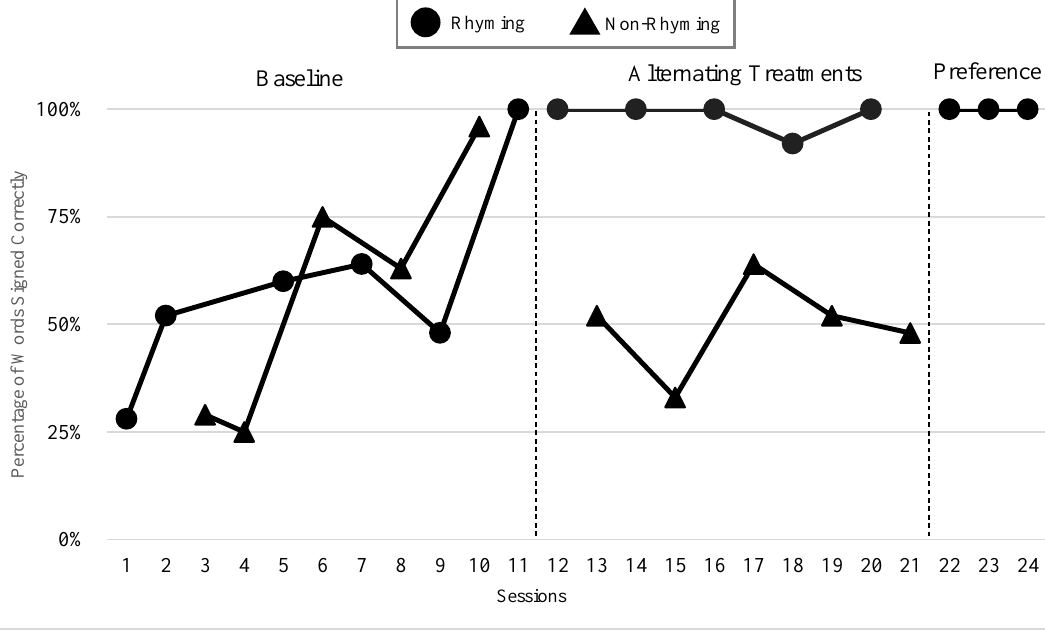
Figure 14. Jaslene’s Percentage of Words Signed in the Correct Order in Recitation. 6.3.4. Lexie Lexie was six years old—the oldest participant in this study—and was adopted from another country two years ago. Lexie came to the United States without any language or lexical vocabulary. After two years of intensive language immersion and support provided by their adoptive deaf parents and teachers of the deaf, Lexie’s language skills in ASL grew to the three-year-old level according to the VCSL. Lexie’s trend and moderate variability between both conditions in the alternating treatments were comparable with the mean percentage of the rhyming condition, being 17% higher than the non-rhyming condition for words signed correctly and 9% higher than the non- rhyming condition for words signed in the correct order. There was a separation in data paths